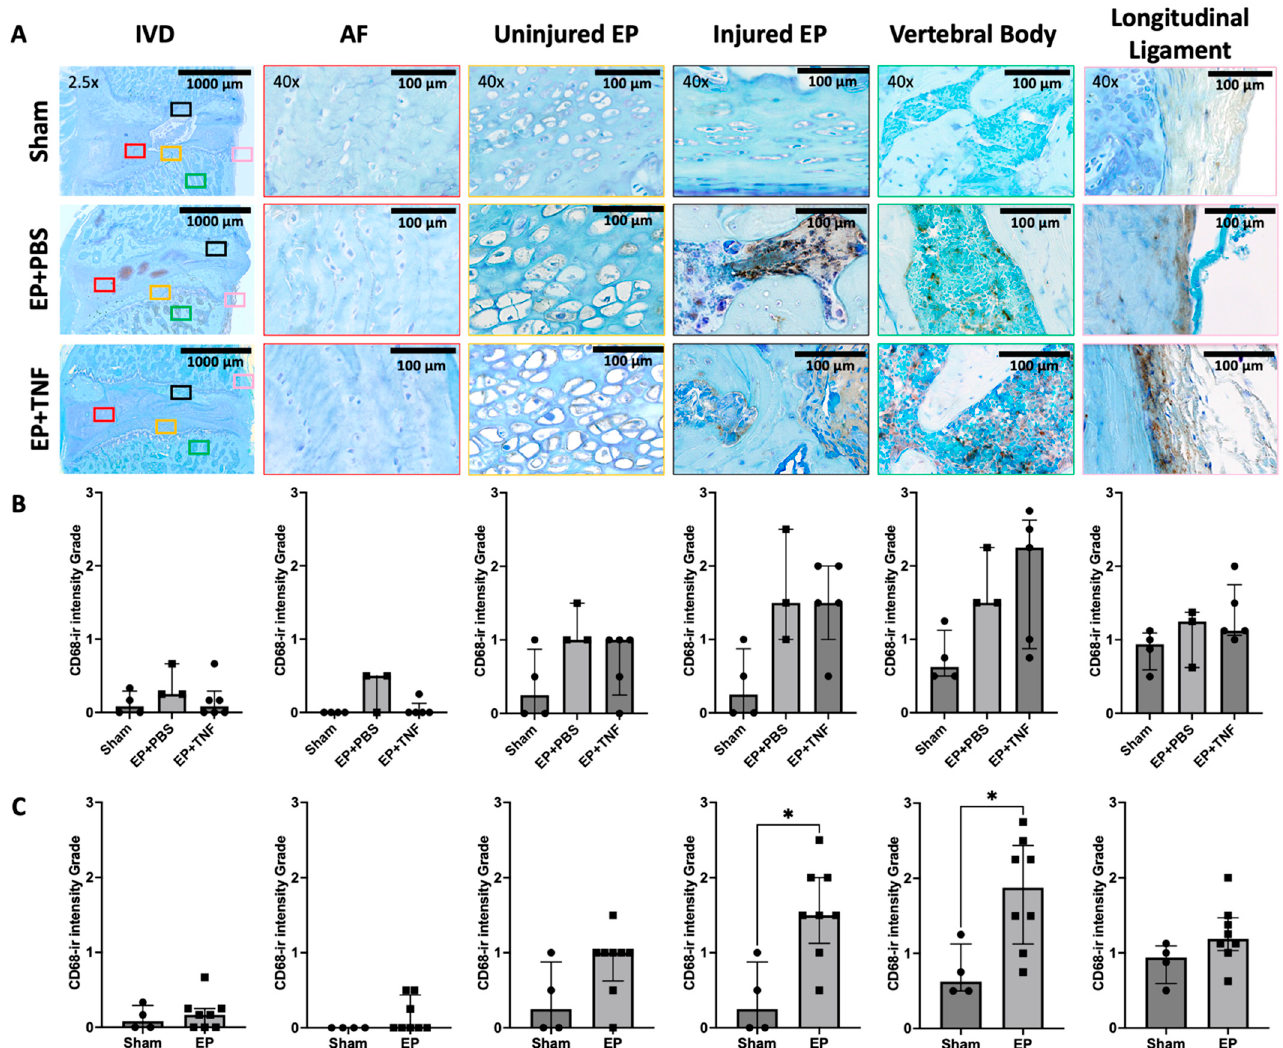
Figure 7. EP injury increased CD68 activity in the spine. ( A ) Representative images of CD68 immunohistochemical staining with toluidine blue in entire IVD, AF, injured and uninjured EP, vertebral body, and longitudinal ligament. ( B ) Semi-quantitative analysis showed EP with PBS and TNF α injections slightly increased CD68-ir in the injured EP and vertebral body, but not to a statistically significant extent. ( C ) Combined EP injury increased CD68-ir in the injured EP and vertebral body. * p < 0.05.